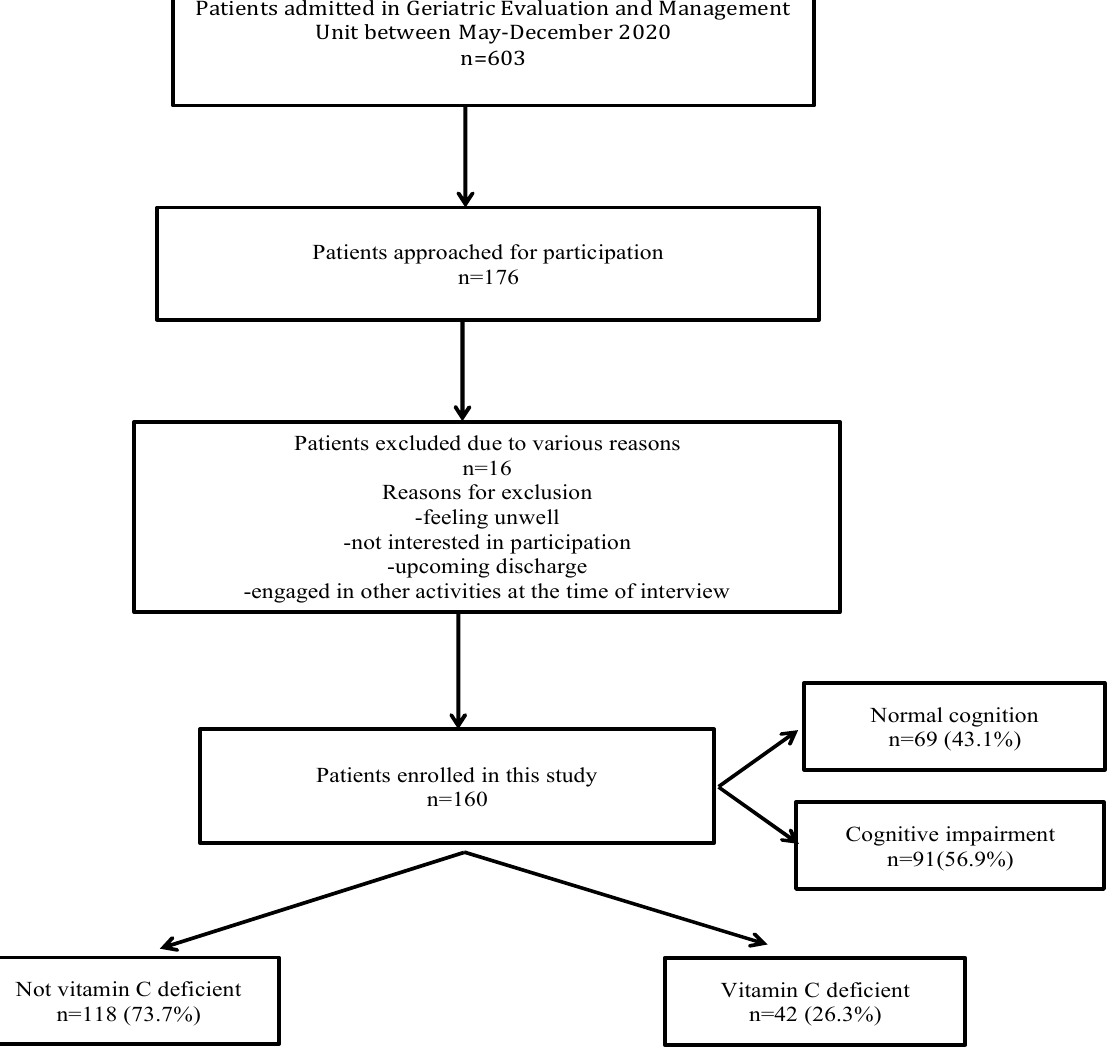
Figure 1. Study flow diagram. The median (IQR) time for the collection of the vitamin C sample after hospital admission was not significantly different between patients who were not vitamin C deficient compared to those who had vitamin C deficiency (4 (4, 3) vs. 4 (4, 4) days, p -value = 0.095). Patients with vitamin C deficiency were more likely to be current smokers with a higher Charlson index and mean creatinine level than patients who were not vitamin C deficient (Table 1). When compared to patients who were not vitamin C deficient, the mean (SD) MMSE scores were significantly lower among patients who were vitamin C deficient (24.9 (3.3) vs. 23.6 (3.4), p -value = 0.03). However, there was no difference in the proportion of patients who made errors on the CDT between the two groups (Table